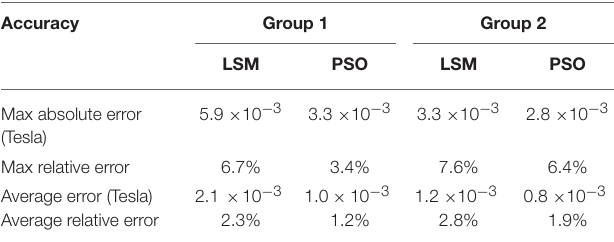
TABLE 2 | Accuracy comparison of PSO and LSM methods on parameter identification of Jiles-Atherton model. Accuracy Group 1 Group